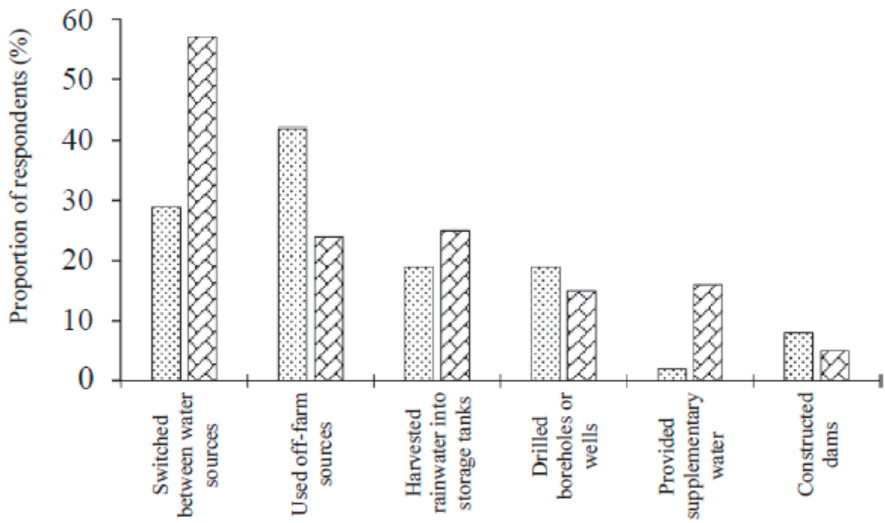
Figure 3. Water scarcity effect between smallholder farmers and commercial farmers [61]. The dotted bar represents commercial farming and the block bar represent smallholder farming level.